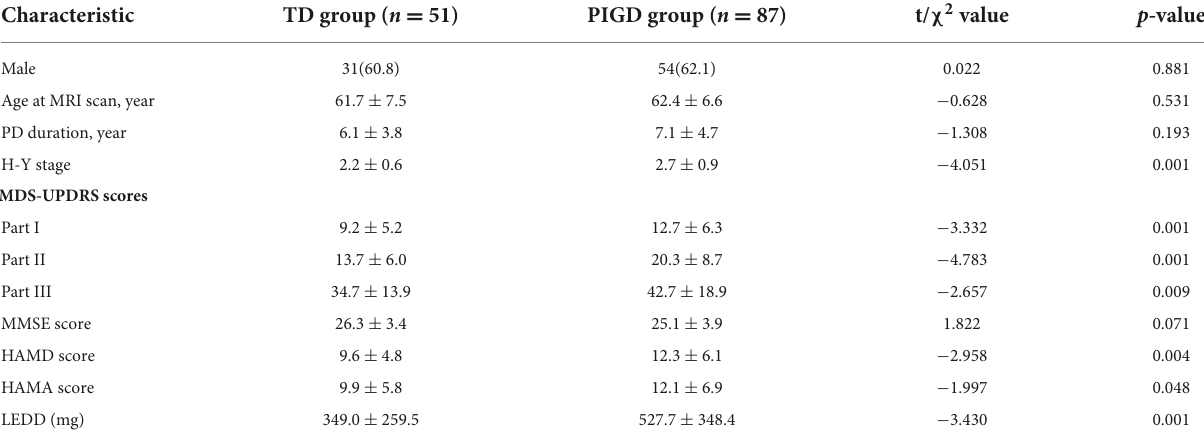
TABLE 1 Clinicodemographic characteristics of Parkinson’s disease